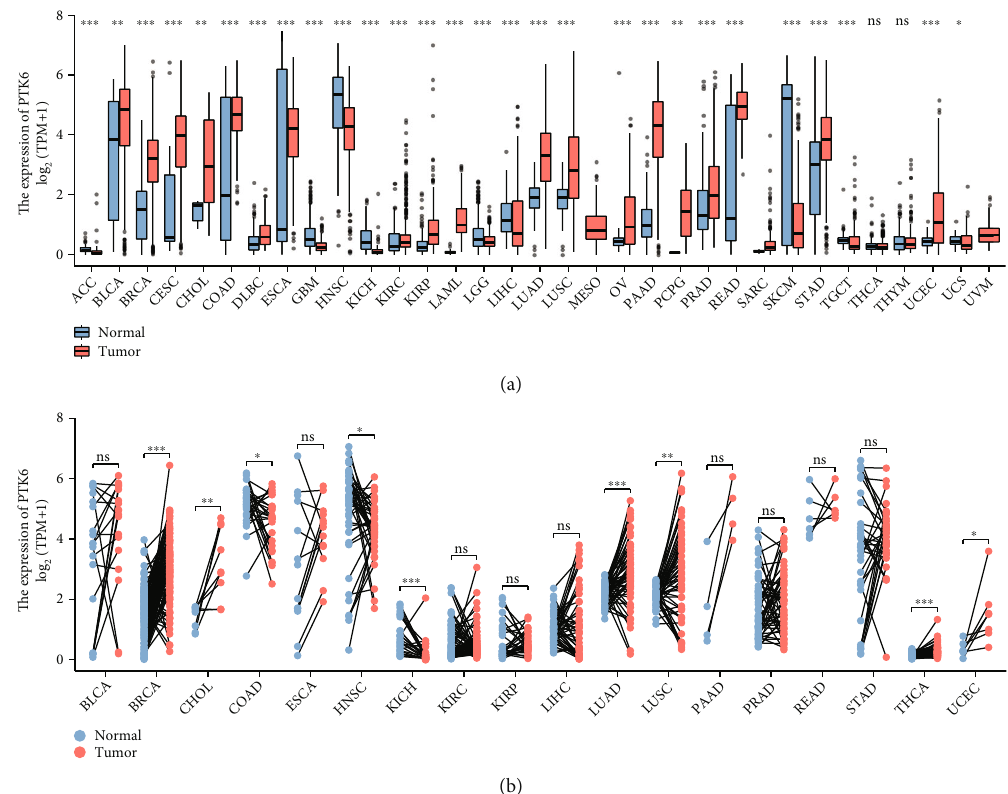
Figure 3: PTK6 pro fi le across cancers. (a, b) The expression of PTK6 across normal and tumor tissues in the TCGA database via (a) unpaired t -test and (b) paired t -test. ∗ p < 0 : 05 , ∗∗ p < 0 : 01 , and ∗∗∗ p < 0 : 001